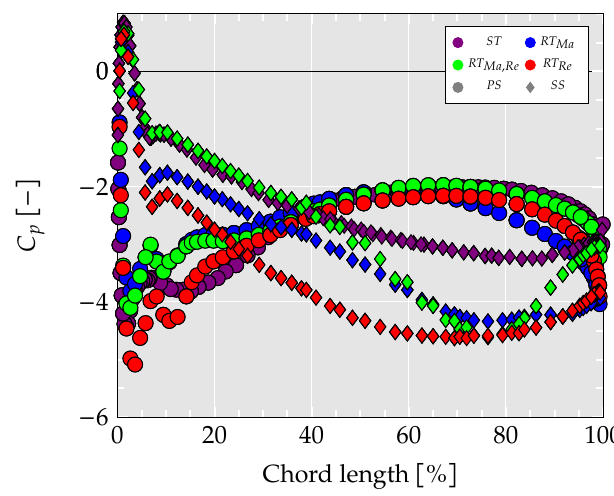
Figure 9. C p coefficient comparison at the midspan.